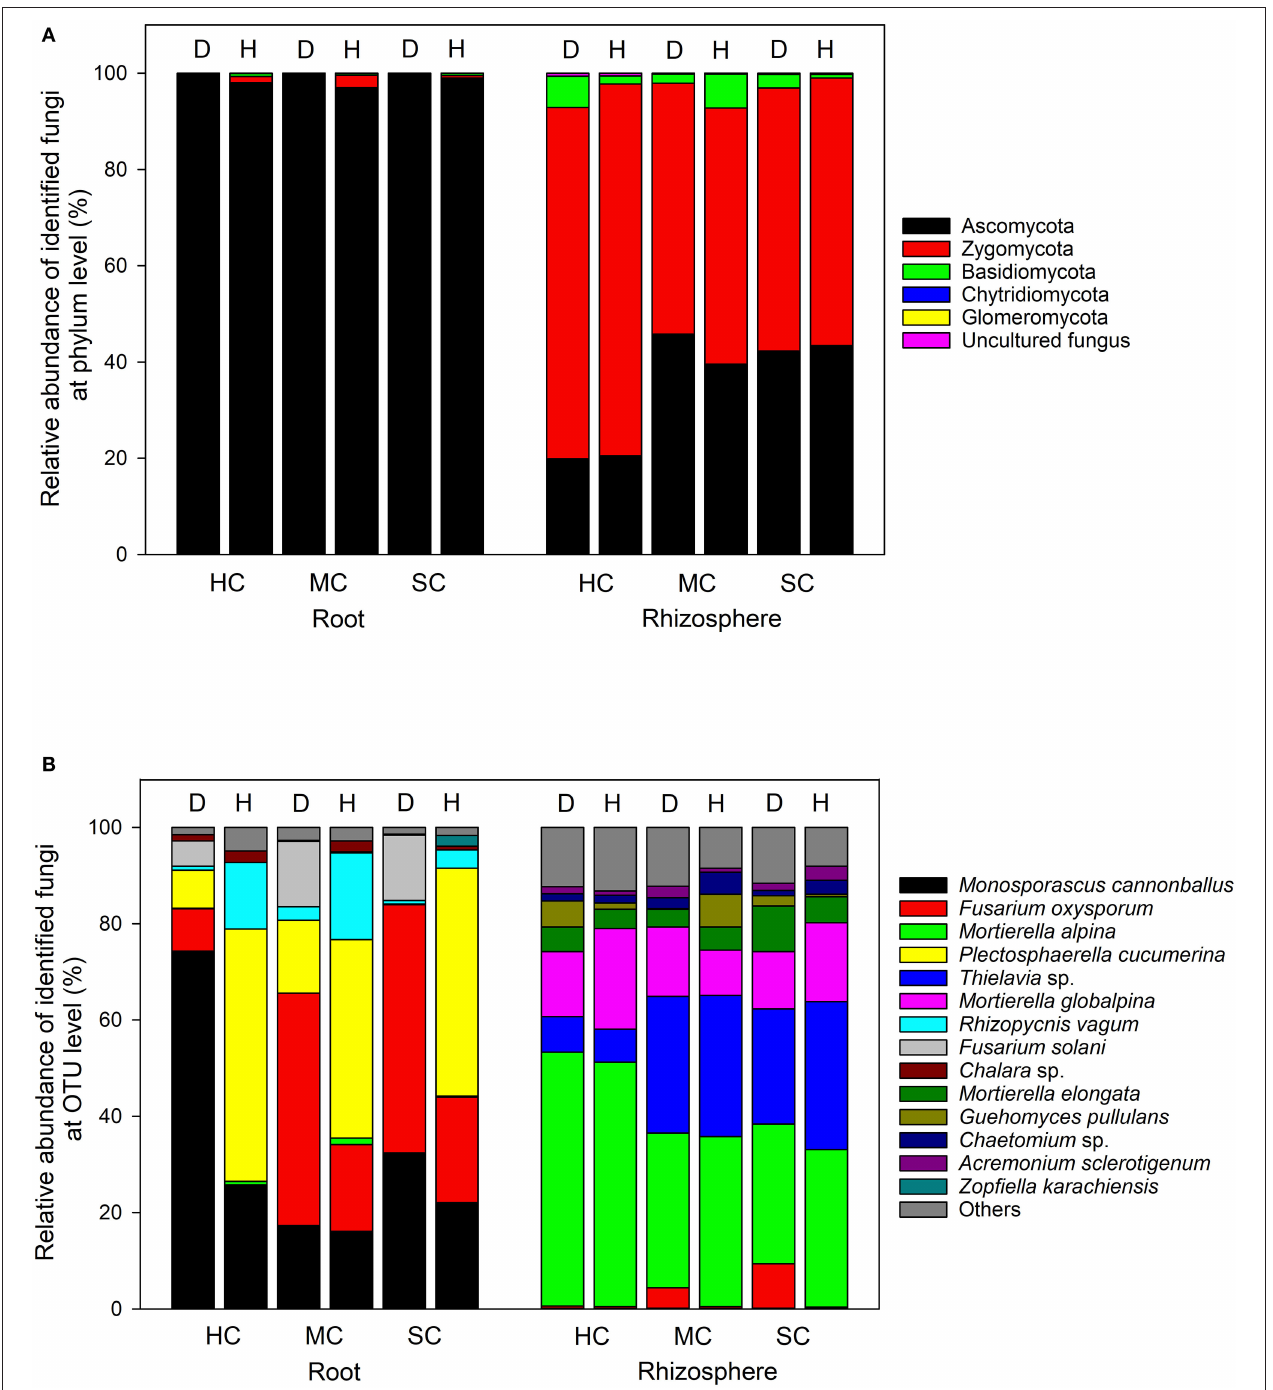
FIGURE 5 | Proportional distribution of different fungal phyla and OTUs in roots and rhizosphere with different symptom severities (D, diseased; H, healthy) and different host genotypes (HC, highly resistant cultivar; MC, moderately resistant cultivar; SC, susceptible cultivar).